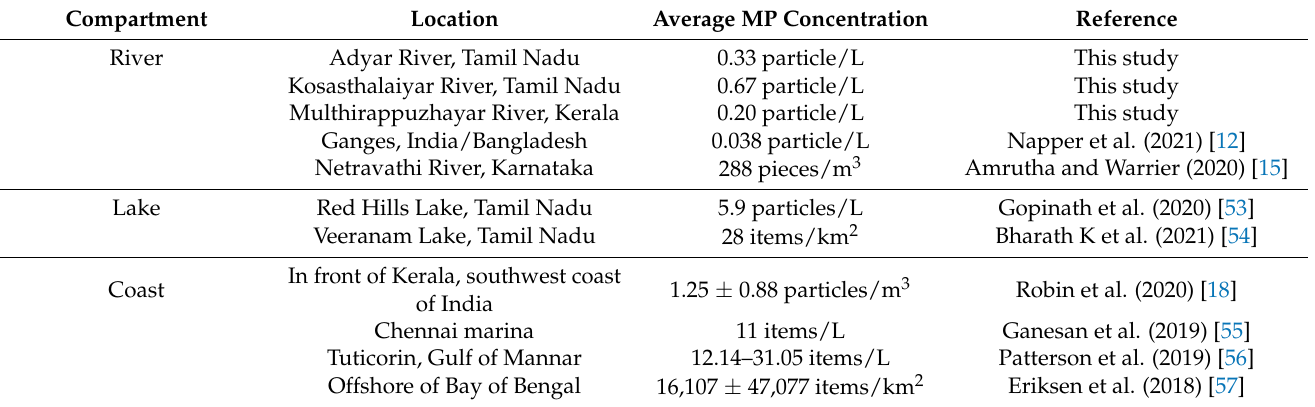
Table 3. Comparison of the detected concentrations of MP in aquatic environments with data from literature.